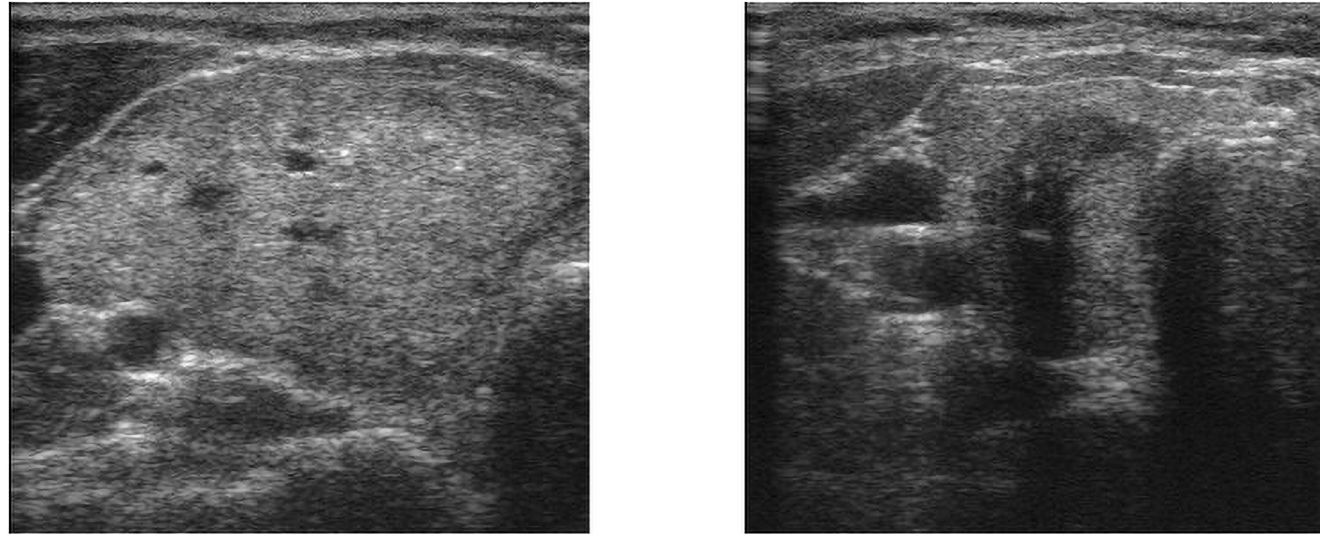
Fig 6. Ultrasound images from DDTI: TIRADS 2 on the left-side with well defined margins and no calcification, labeled as “benign”; TIRADS 5 on the right-side with micro-calcification, labeled as “malignant”.